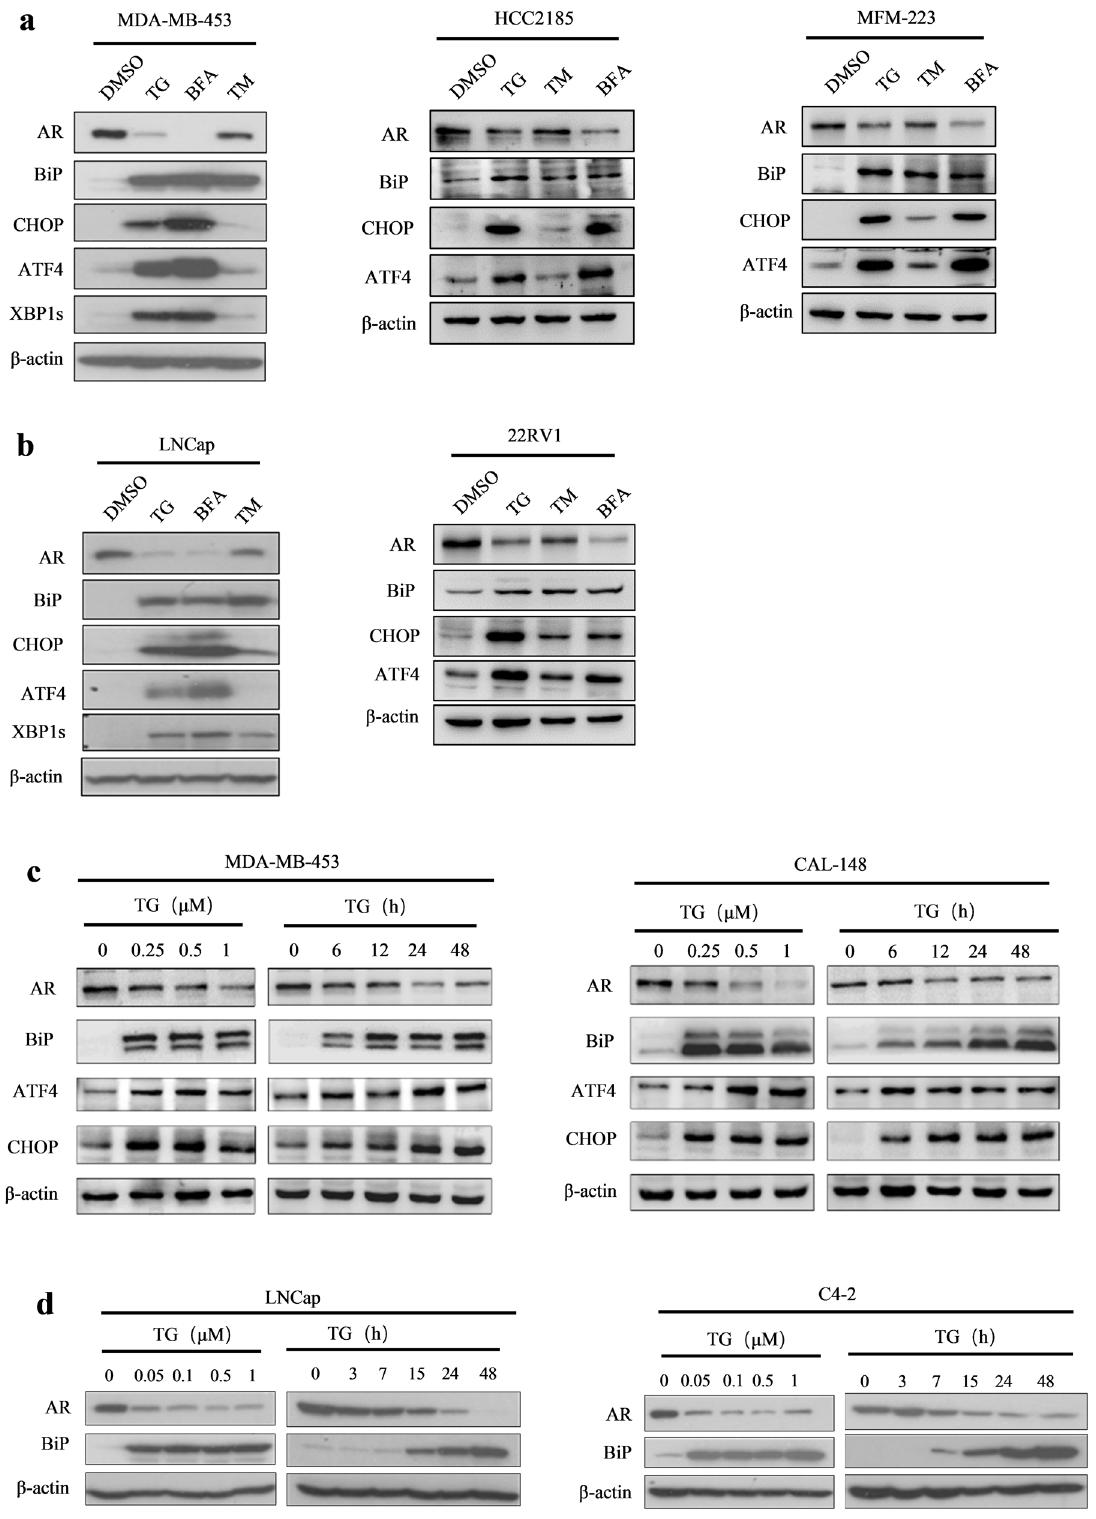
Fig. 1 ER-stress inducers decreased AR protein expression in LAR TNBC and PCa cells. a, b MDA-MB-453, HCC2185, and MFM-223 cells ( a ), LNCap, and 22RV1 cells ( b ) were treated with 1 μ M TG, 5 μ g/mL BFA or 4 μ g/mLTM for 24 h and collected for western blotting assay. c , d MDA- MB-453 and CAL-148 ( c ), LNCap and C4-2 ( d ) cells were treated with TG for 24 h or with 1 μ M TG for the indicated time, and then cells were collected for western blotting assay. Thapsigargin, brefeldin A and tunicamycin are abbreviated as TG, BFA, and TM,